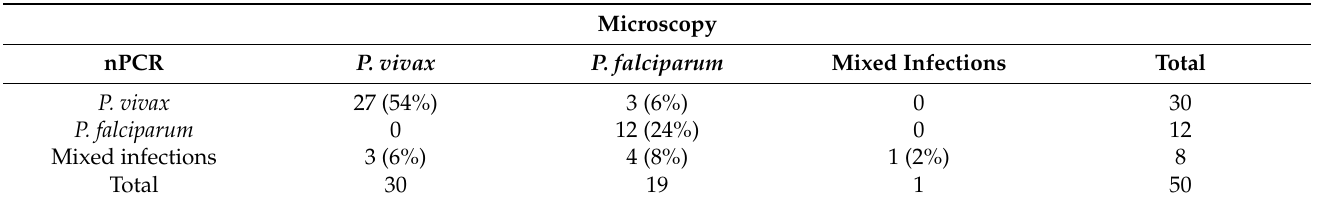
Table 3. Concordance in the diagnosis of Plasmodium species between microscopy and nested